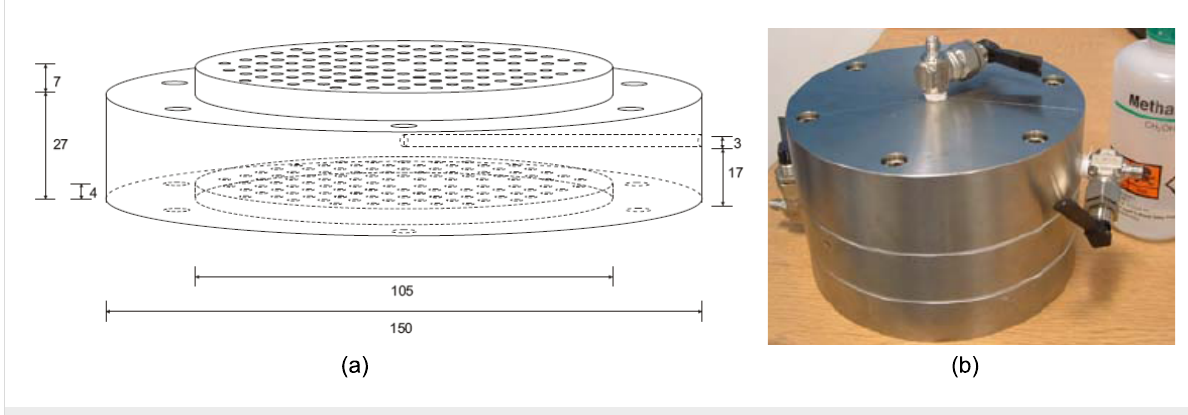
Figure 2: (a) : Schematic diagram of the parallel reactor housing (dimensions in mm); (b) the stainless steel parallel flow reactor with the reactor housing sat between the flow inlet manifold (bottom) and headspace with gas and liquid outlets (top).